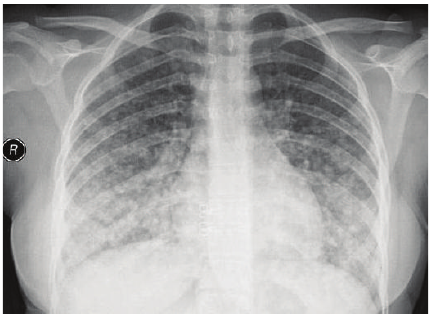
Figure 1: In the chest radiography, widespread nodular opacities are seen in all the zones, which are intensified in the lower zones.